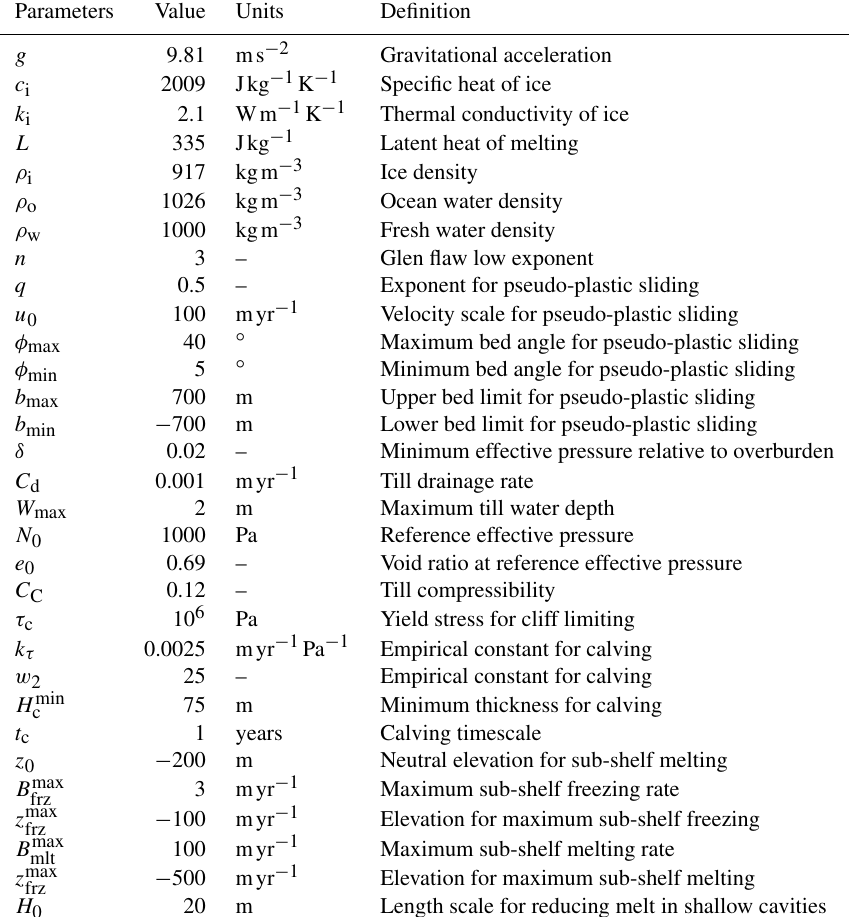
Table 2. Model constant and parameter values used for simulations described in the text. The calving and sub-shelf melting parameters are used only for simulations with ice shelves; other parameters are used for all Greenland